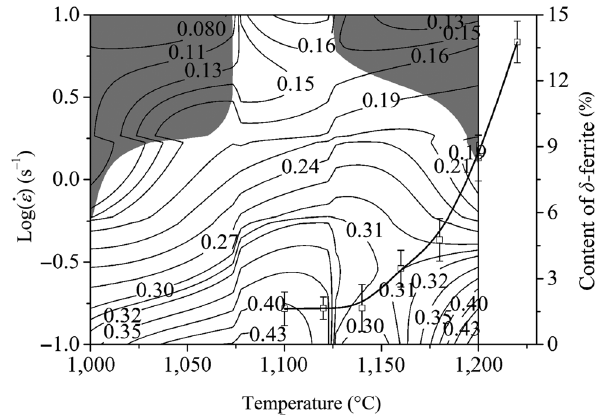
Figure 16: The relationship between the percentage of delta-ferrite and the